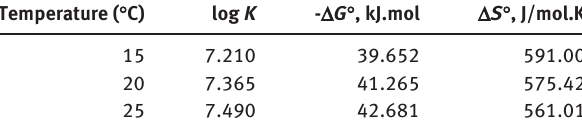
Table 4 Formation constant values and thermodynamic parameters for adrenaline-iron(III) at different temperatures.